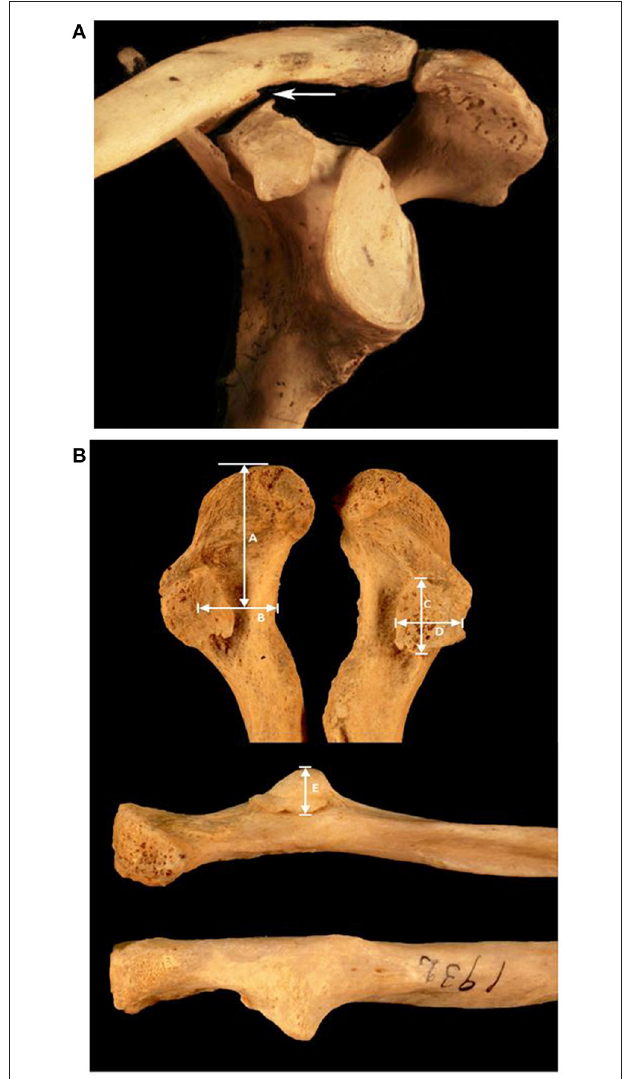
FIGURE 1 | (A) Articulated CCJ. This image is an anterolateral view of an articulated scapula and clavicle, with an arrow pointing to the CCJ. (B) Clavicular facet. The upper image shows an inferior view of the clavicles from an individual with bilateral facets. The lower images show the elevation of the facet in anterior (middle image) and posterior views. Morphologic measurements include A: distance from acromio-clavicular joint to midpoint of facet, B: distance from anterior border of clavicle to midpoint of facet, C: facet length, D: facet width, E: facet